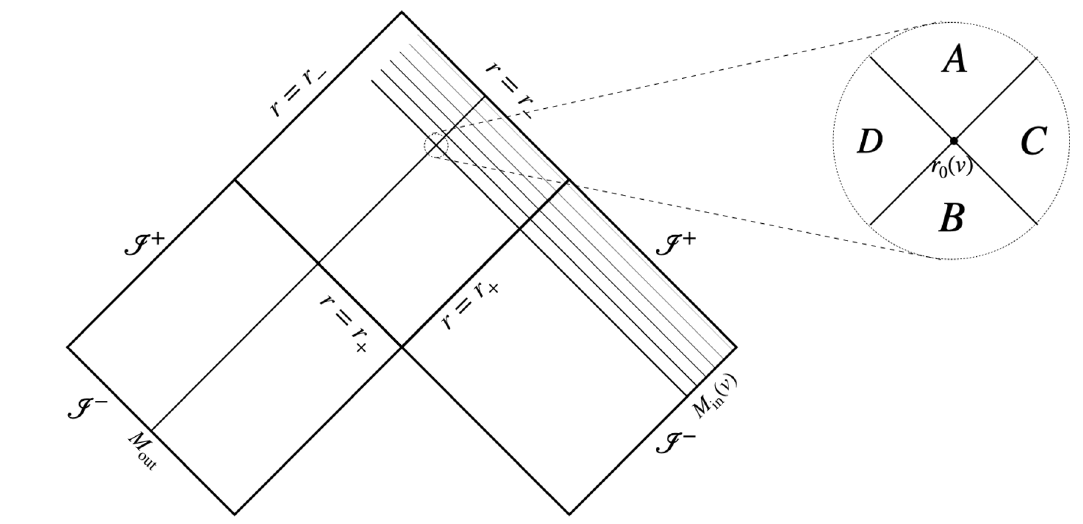
Figure 1 . Schematic representation of the relevant sections of the Penrose’s diagram of a regular black hole. A pair of outgoing/ingoing null shells cross at a point r 0 ( v ) close to the inner horizon dividing the spacetime into four regions (A, B, C and D). We will consider several ingoing shells and analyze the behavior of the system as the point r 0 ( v ) is displaced along the outgoing null